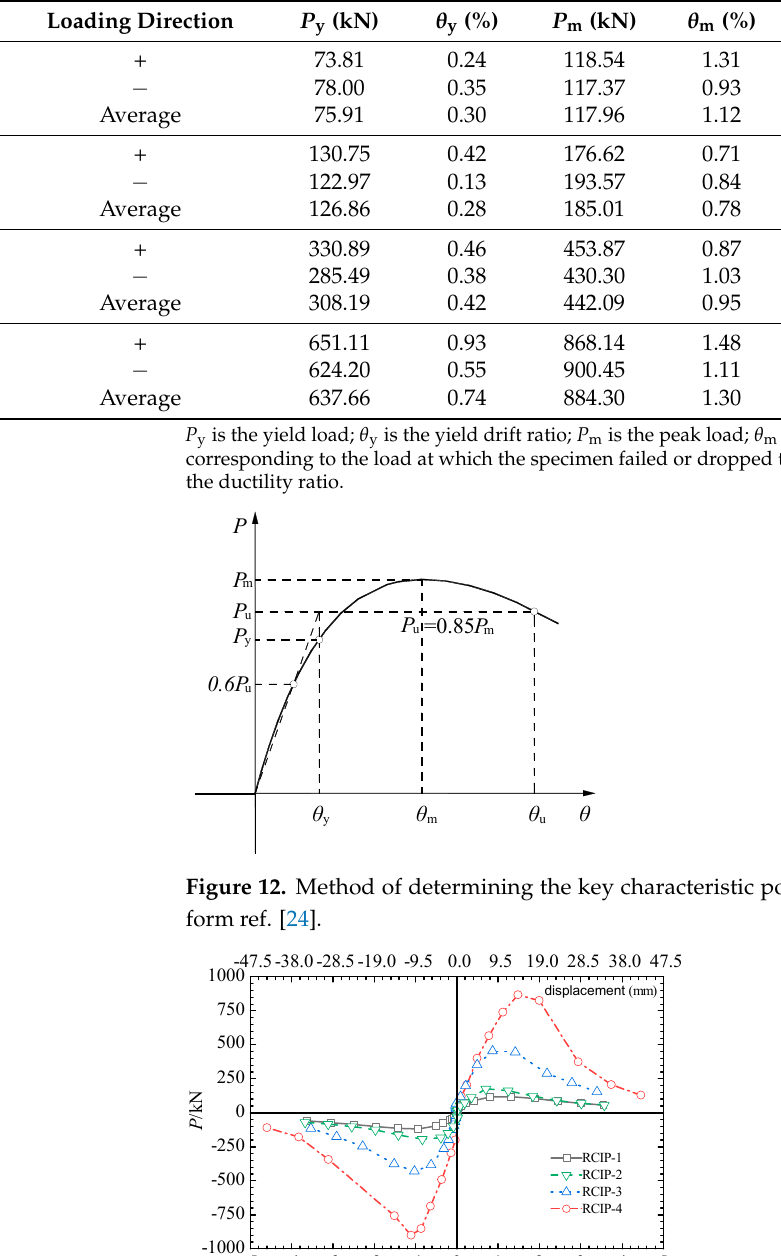
Table 3. Characteristic lateral loading responses.